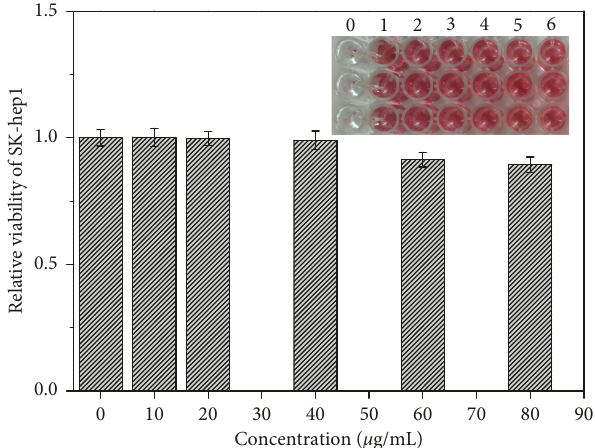
Figure 8: Viability of SK-hep1 incubated with different concen- trations of NRPCNSs (0, 10, 20, 40, 60, and 80 μ g/mL) for 24h. Inset (from 1 to 6): visual observation of the corresponding so- lutions of MTT assay; the background is marked 0. Data are mean ± SD (bars) ( n �